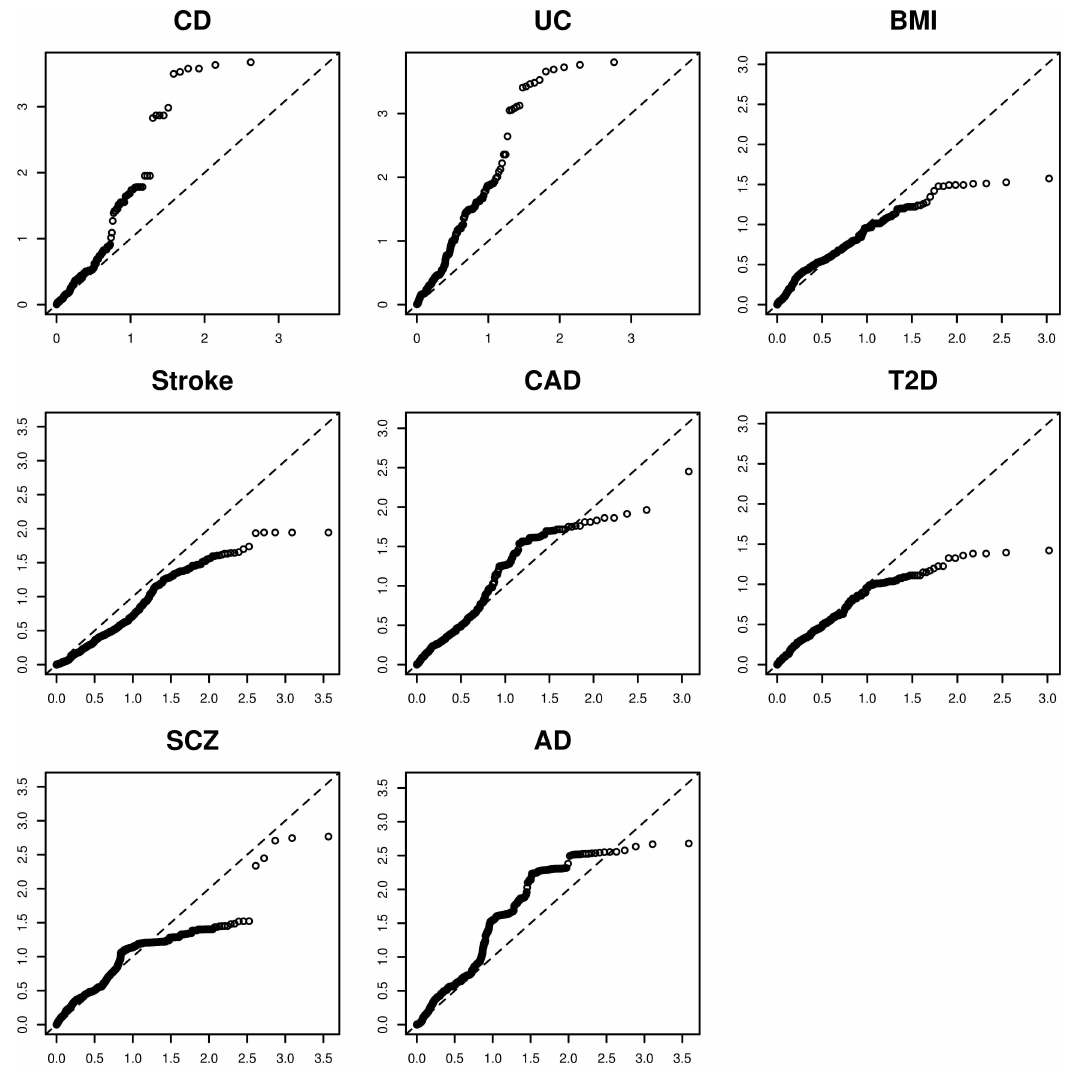
Fig 4. Enrichment for GWAS signals in blood protein-QTLs of CD patients. Expected uniform -log10(relative rank) of the protein-SNPs (nominalpvalue (cid:20) 1E-5) within the full GWAS SNPs list on the horizontalaxis; observed–log10(relative rank) on the vertical axis. CD: Crohn’sDisease; UC: UlcerativeColitis; BMI: Body Mass Index; SCZ: Schizofrenia; Stroke: Ischemic Stroke; T2D: Type-2 Diabetes. Referencesfor all the studies are reportedin the